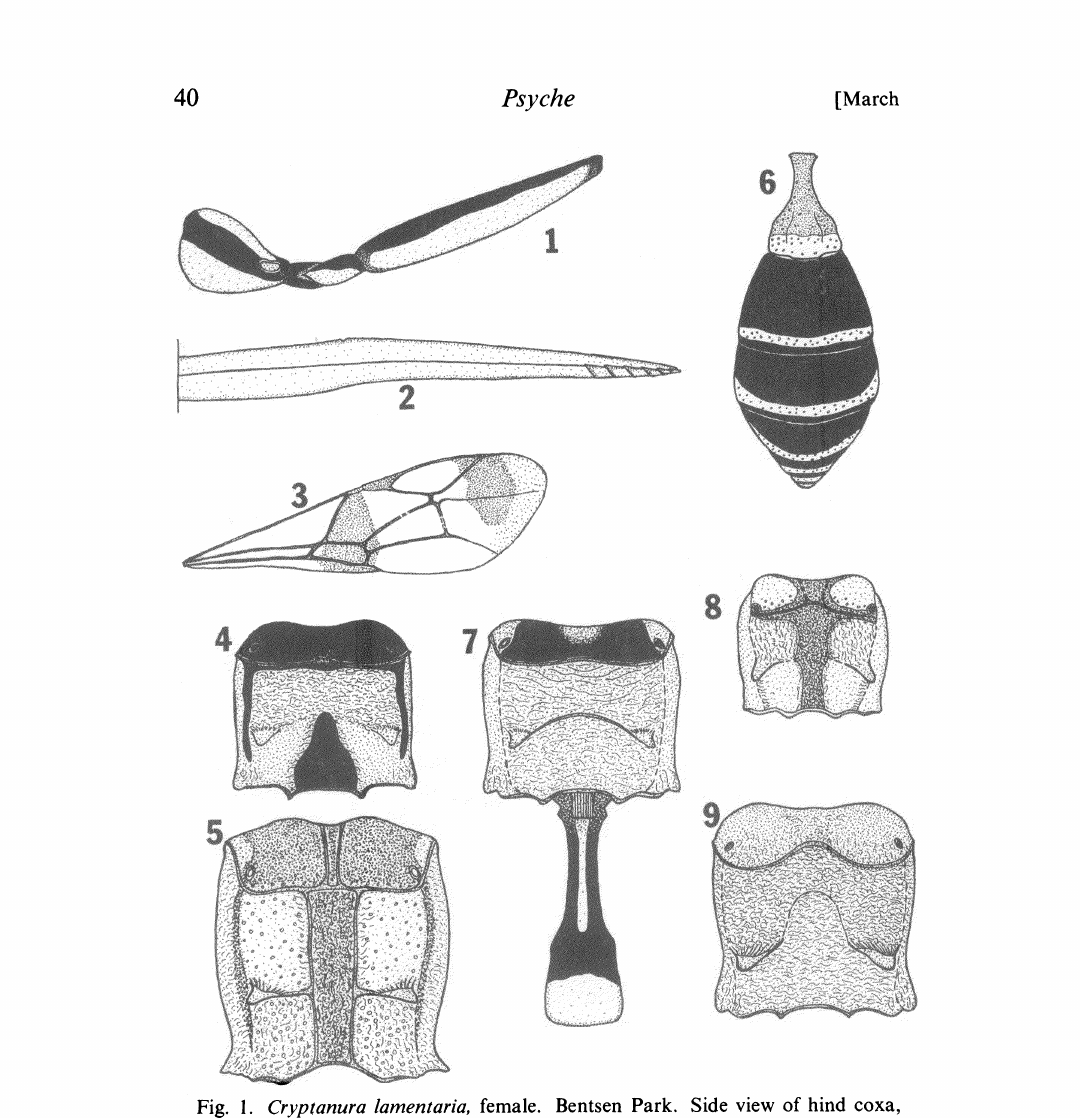
Fig. 1. Cryptanura lamentaria, female. Bentsen Park. Side view of hind coxa, trochanters, and femur, showing color pattern. Fig. 2o Mesostenus opuntiae, female holotype. Ovipositor tip. Fig. 3. Lymeon leucosoma, female. Valley Botanical Garden. Fore wing. Fig. 4. Diapetimorpha aspila, male holotype. Dorsal view of propodeum. Fig. 5. Bicristella taxana, female holotype. Dorsal view of propodeum. Fig. 6. Trachysphyrus mesorufus, female. Valley Botanical Garden. Dorsal view of gaster, showing color pattern. Fig. 7. Diapetimorpha pareia, male holotype. Dorsal view of propodeum and first gastric segment. Fig. 8. Cryptanura vallis, fe- male holotype. Dorsal view of propodeum. Fig. 9. Diapetimorpha sphenos, female paratype. Dorsal view of